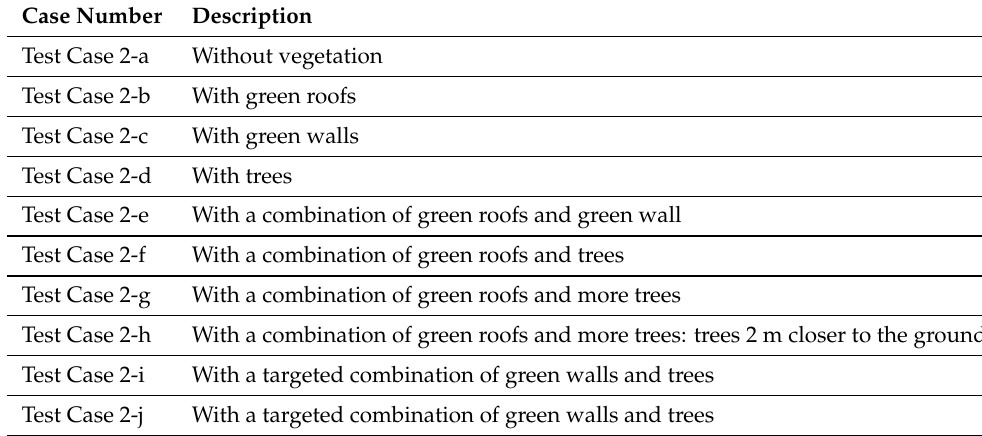
Table 2. Test Case 2 with various forms of